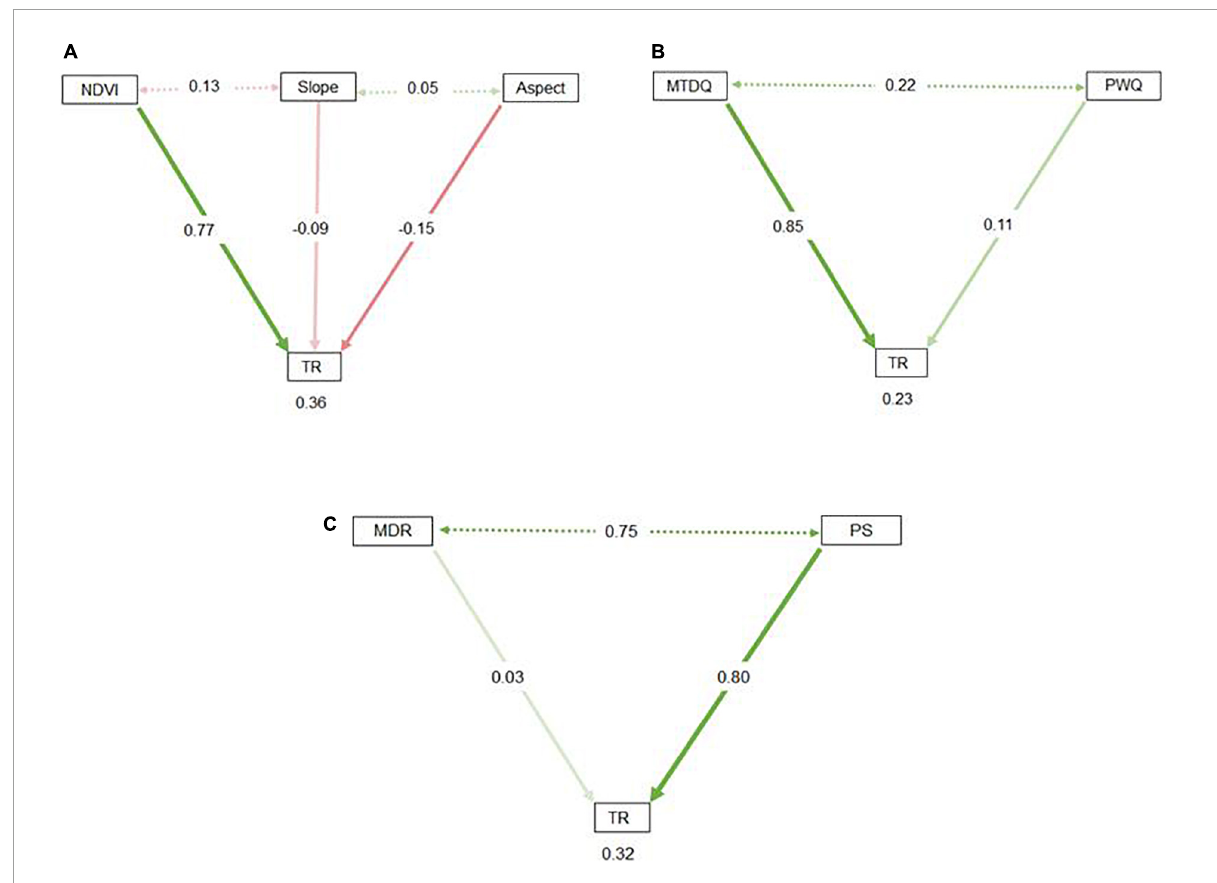
FIGURE5 SEM output to evaluate the significance of environmental determinants: (A) Habitat heterogeneity, (B) water–energy, and (C) climate stability on tree richness